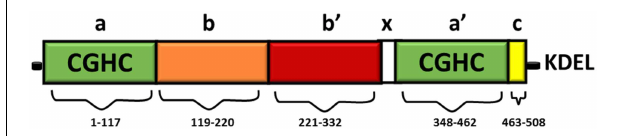
FIGURE 1 | Domain structure of PDI. The thioredoxin-like domains are shown in green, representing the catalytically active domains a and a’ . The catalytically inactive b domain and b’ domains are illustrated in orange and red respectively. The linker region x (shown in white) is responsible for the U shape structure of PDI. The C terminus is illustrated in yellow, followed by an ER retrieval signal,